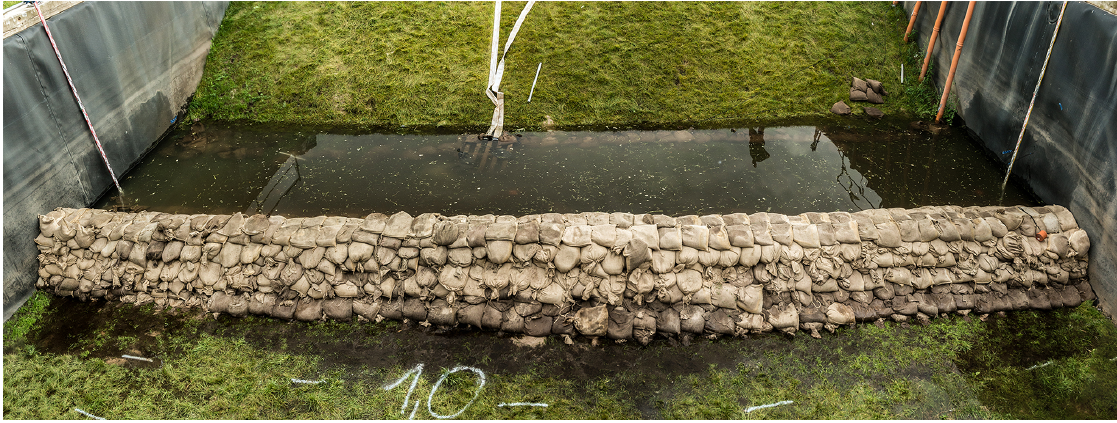
Figure 6. Sandbag dam in the IWA test